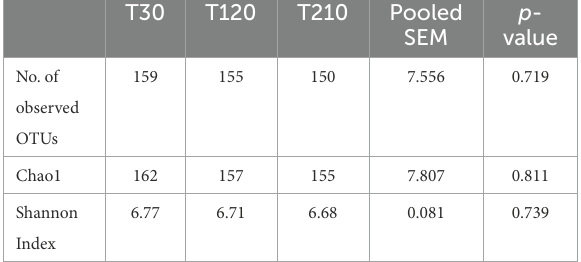
All data, except for the number of dogs that reached the target body weight, are expressed as median [range]. a BCS based on 9 point scale (Laflamme, 1997). b Expressed as the percentage of starting body weight. Positive values indicate a net loss, negative value indicate a net gain. c Expressed as the percentage of starting body weight lost per week. d Expressed as kcal of ME per kg 0.75 of target body weight. TABLE 7 Fecal pH values and concentrations of ammonia ( μ mol/g), volatile fatty acids ( μ mol/g) and biogenic amines (nmol/g) in feces of obese dogs ( n = 16) before (T30), after 90 days (T120) and at the end (T210) of caloric restriction (phase 2 of the study).